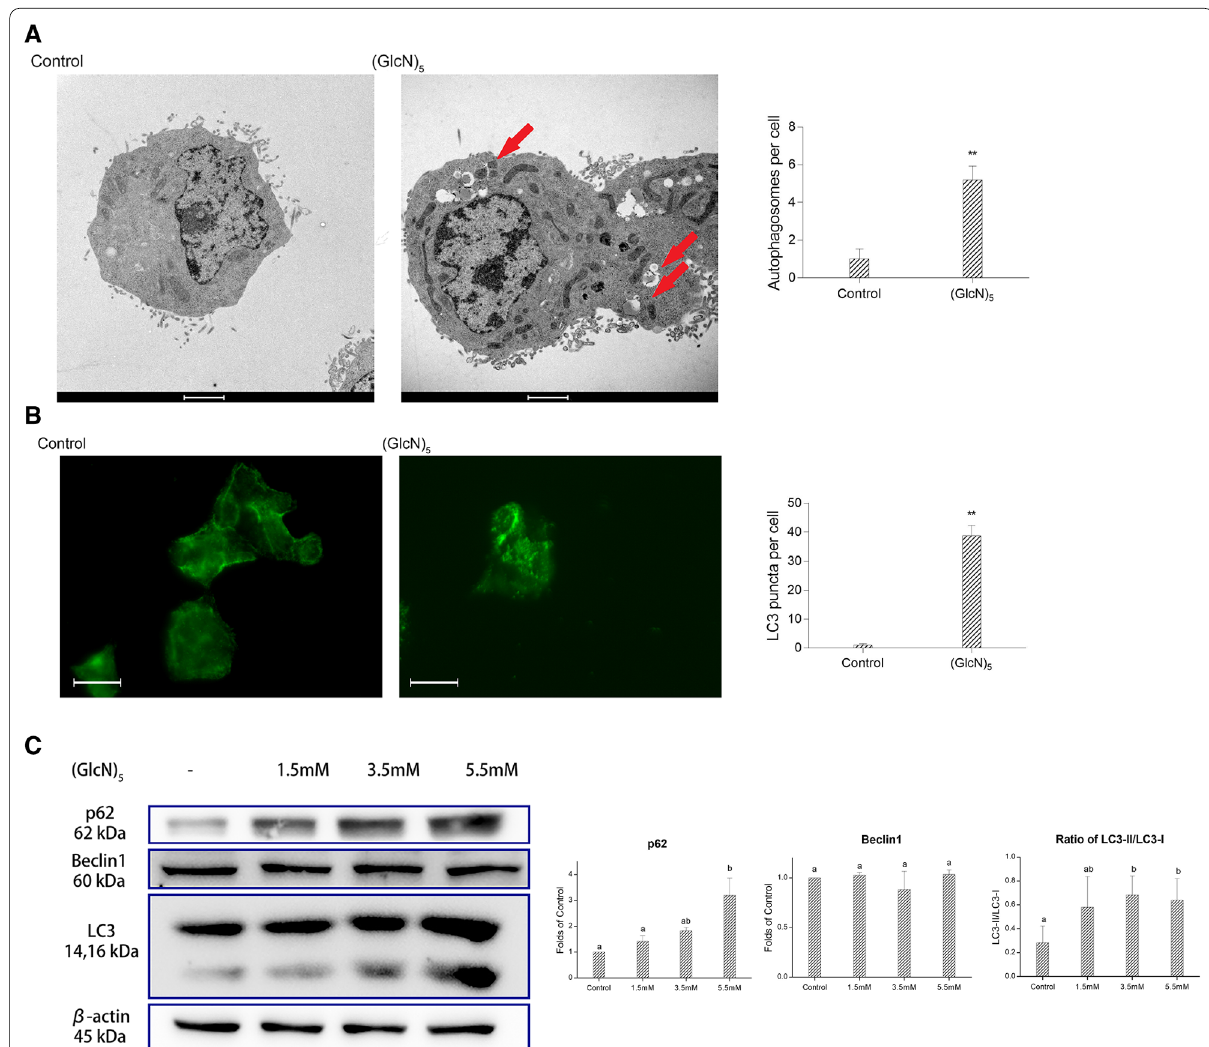
Fig. 5 (GlcN) 5 increased autophagy markers. A Representative image of TEM. Scale bar represents 2 μm. Autophagosomes per cell were counted and quantified. B Immunofluorescence results for LC3 puncta detection. Scale bar represents 50 μm. LC3 puncta per cell were counted and quantified. C Western blot analysis for p62, Beclin1, and LC3B. Cells were treated with different concentration of (GlcN) 5 . Cells were treated with or without (GlcN) 5 (3.5 mM). Data were represented as mean SD Significance between groups was marked by various letters, a, b, c, etc. (One-way ± ANOVA). **, p < 0.01, ***, p < 0.001